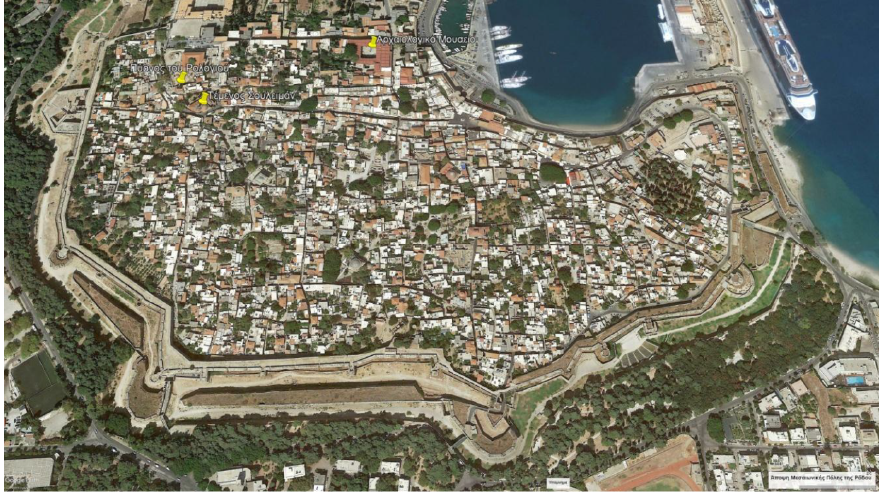
Figure 1. The medieval city of Rhodes (Google maps).